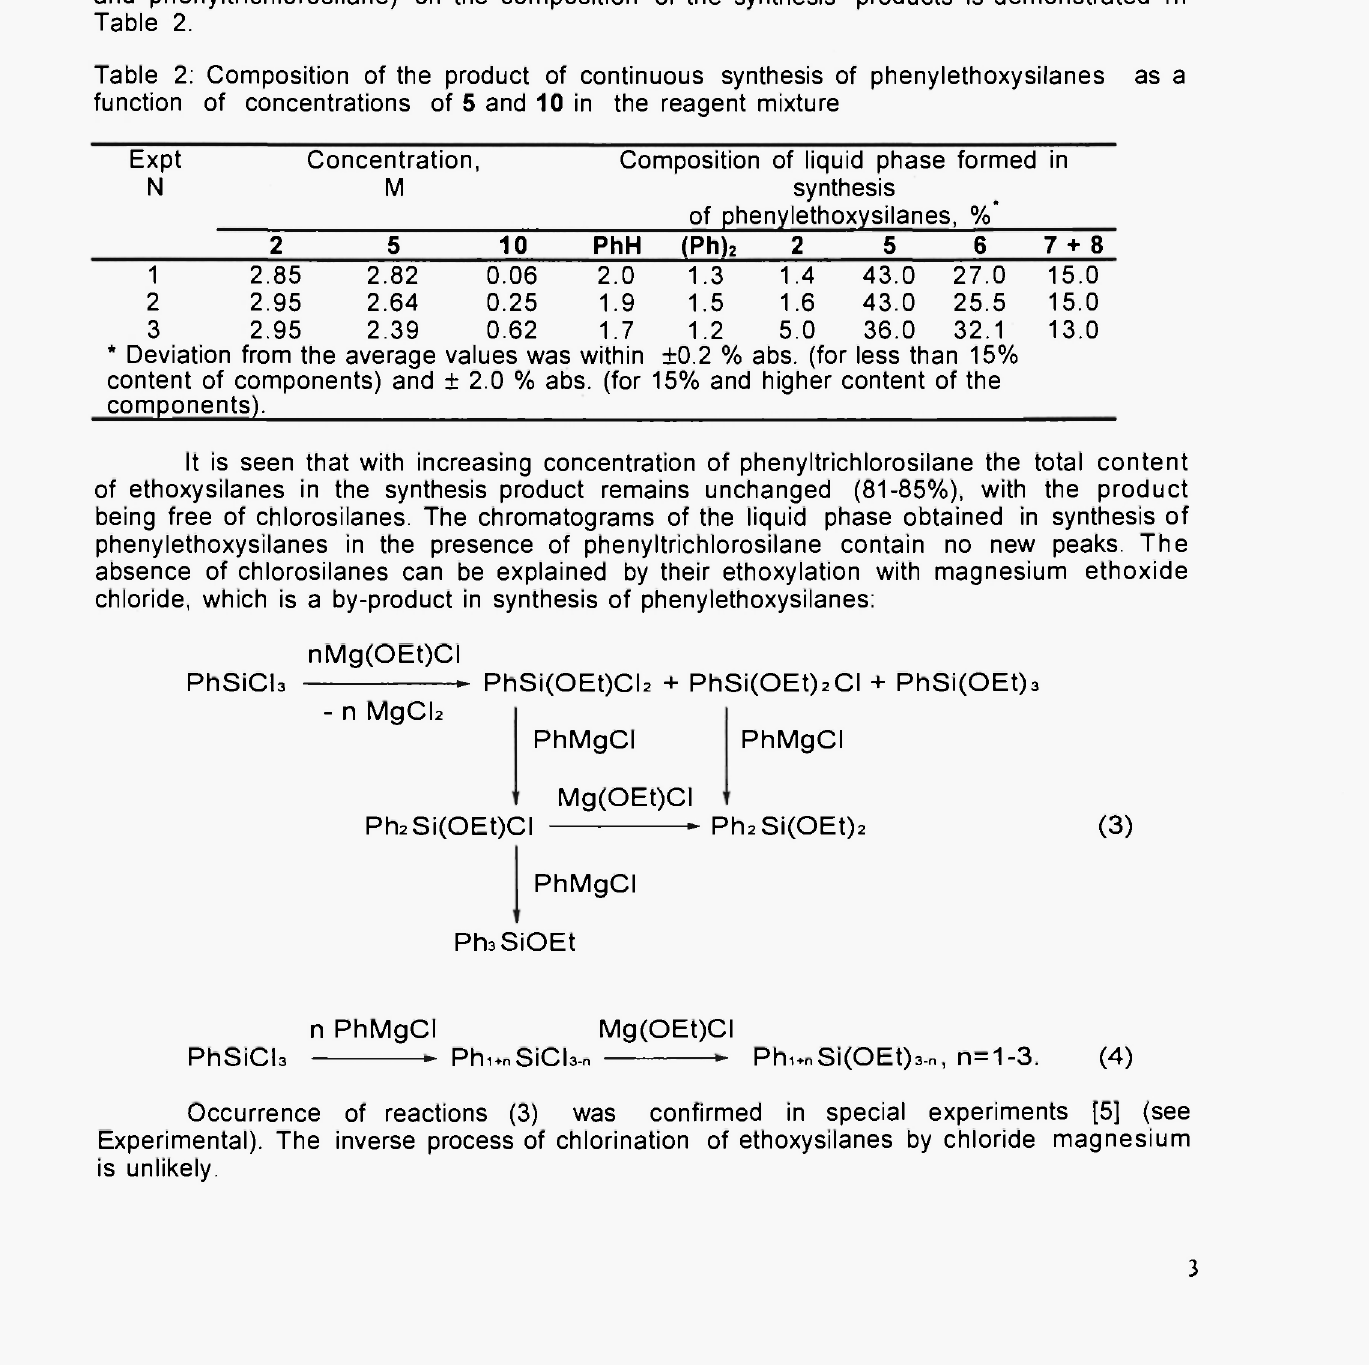
Table 2: Composition of the product of continuous synthesis of phenylethoxysilanes as a function of concentrations of 5 and 10 in the reagent mixture Expt Concentration, Composition of liquid phase formed in Μ